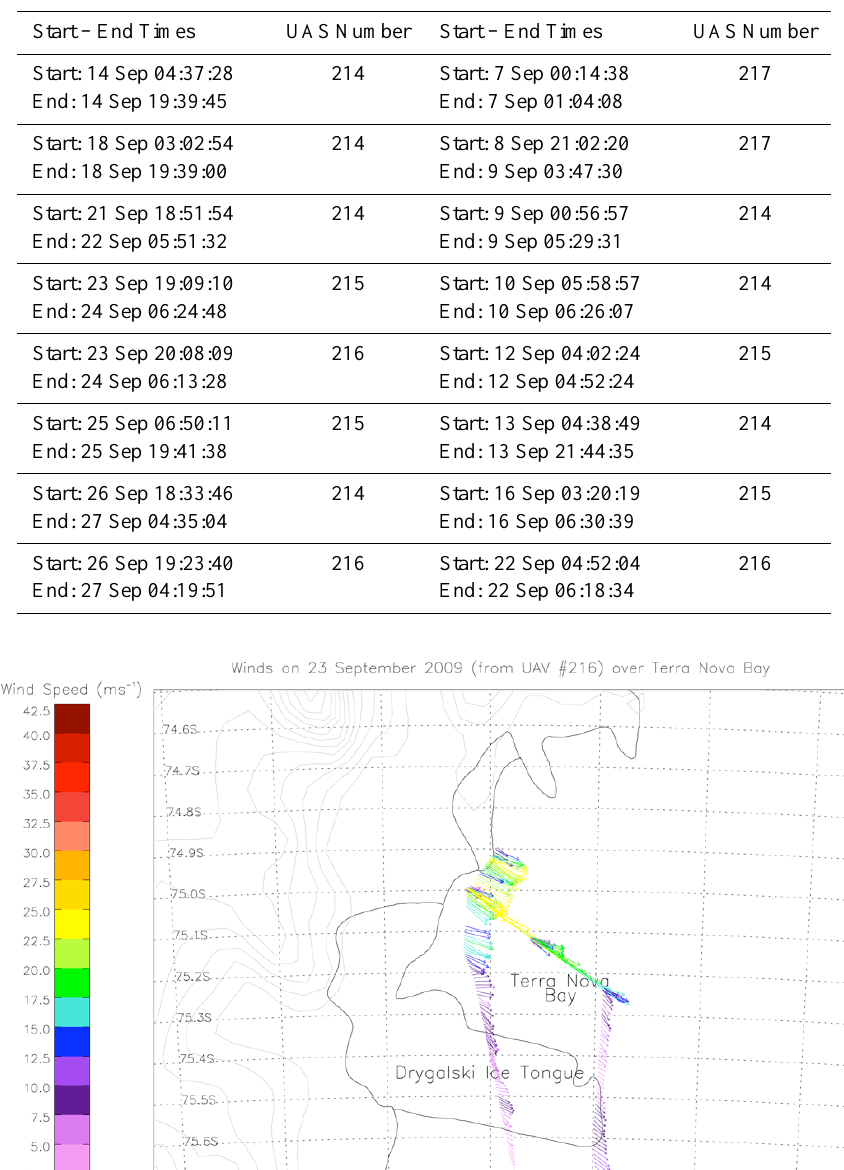
Table 1. Start and end times (in UTC) and the UAS aircraft number for science flights to TNB and local flights near Pegasus ice runway. Science Flights